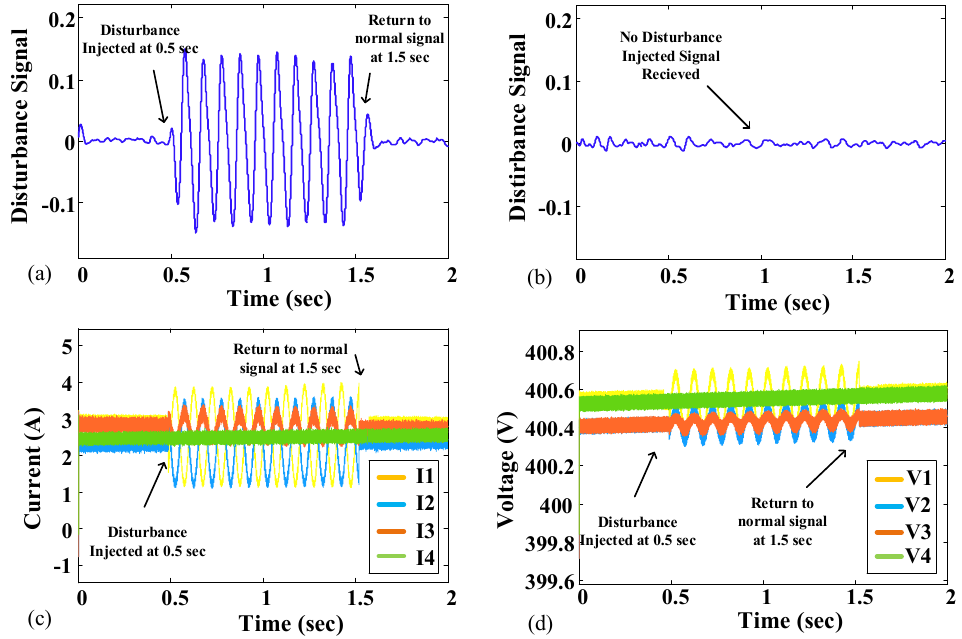
Figure 8. Case Study Result ( a ) Disturbance Signal Received at Every Connected Node, ( b ) Discon- nected Node 4, ( c ) Node Current, ( d ) Node Voltages.